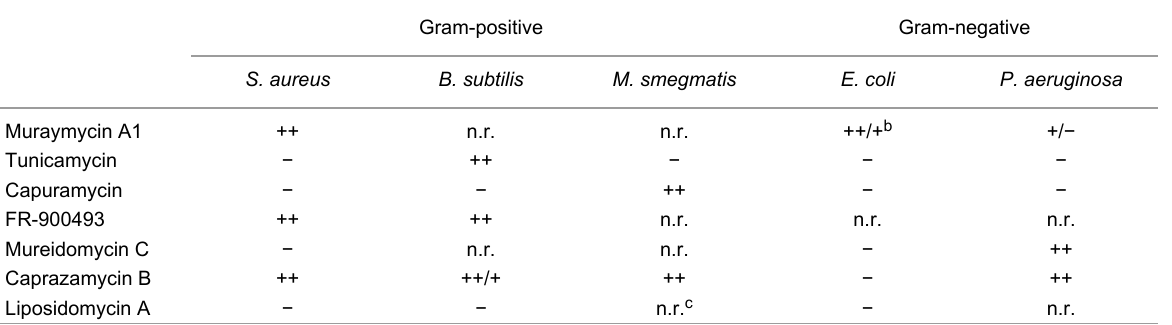
Table 1: Comparison of the antimicrobial activities of selected representative compounds of different classes of nucleoside antibiotics against selected bacterial species. a Gram-positive Gram-negative